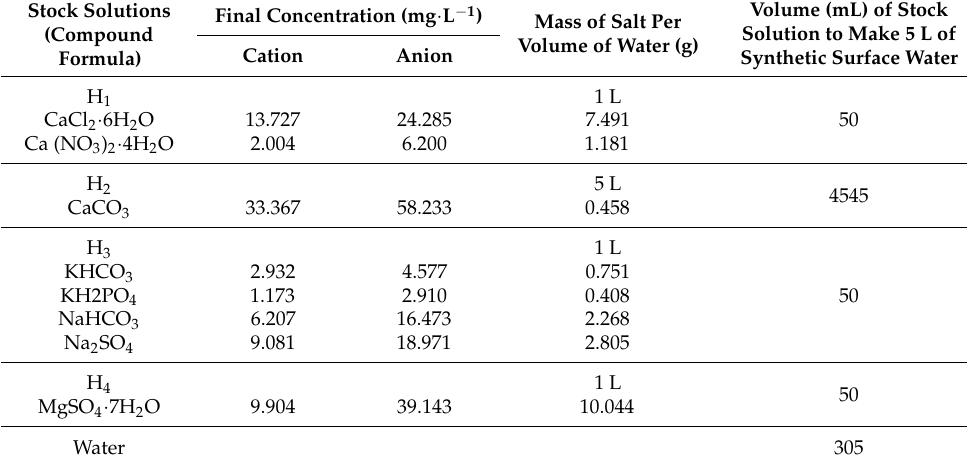
Table 3. Synthetic surface water recipe (Rostherne Mere (Lancashire)